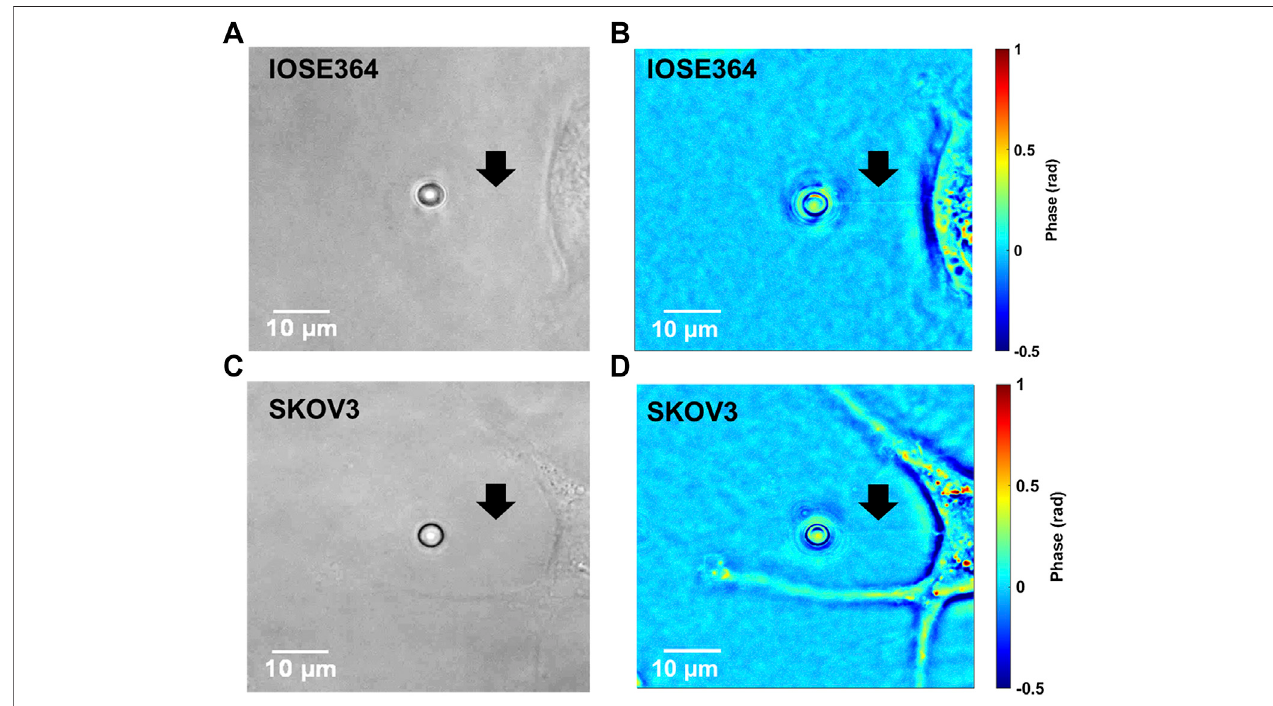
FIGURE 5 | Representative images of IOSE364 and SKOV3 cells obtained by (A,C) bright fi eld microscopy, and (B,D) QPI. Arrows point to tethers, which are not visible under bright fi eld, but become resolvable by QPI. Membrane protrusions from SKOV3 cells can also be visualized at improved contrast by QPI.